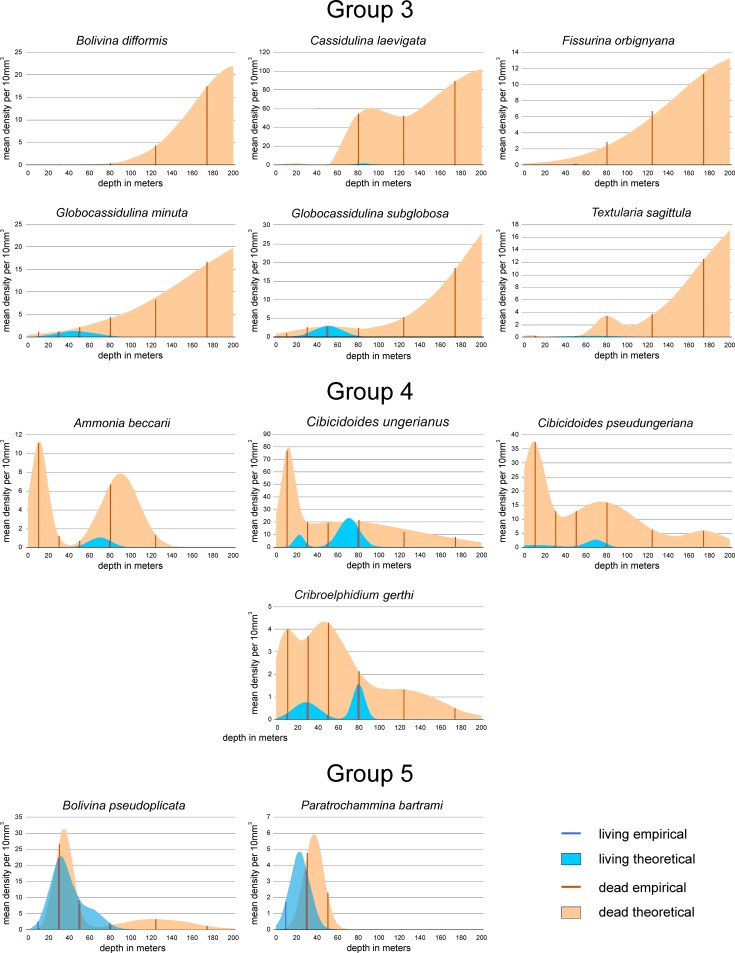
Depth frequencies of living and dead individuals for species of groups 3 to 5 according to UPGMA cluster analysis.Groups are positioned in the CCA of Fig 12.